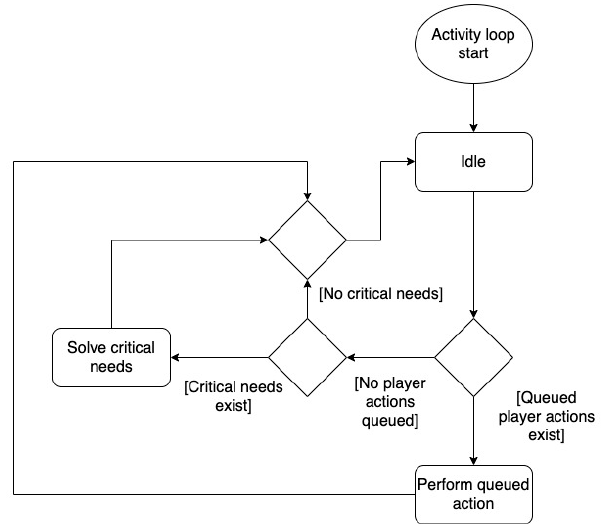
Figure 2. Basic activity loop of the game character. The game character is, most of the time, strolling idly, acting only when the player queues or when the character must act in solving a need that reaches critical